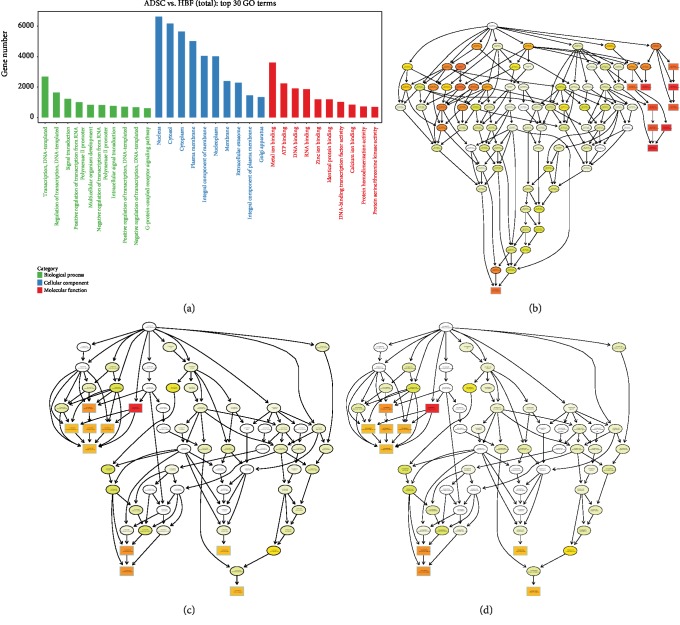
Target gene GO enrichment analysis. (a) Bar chart represents the top 10 GO entries in the three categories. (b–d) Target gene topGO directed acyclic graph. The biological process (a), cellular component, (b) and molecular function (c) of target genes predicted by differential miRNAs in each group. Each GO term is enriched, and the most prominent 10 nodes are represented by a rectangle. The color of the rectangle represents enrichment significance, and the higher the saliency from yellow to red. The basic information of each node is displayed in the corresponding graph, which is GO ID and GO term.